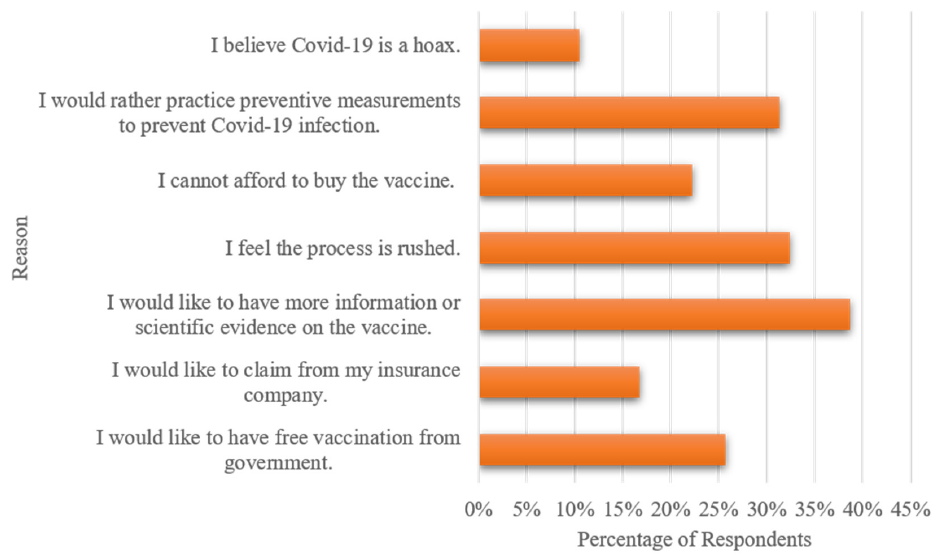
Figure 1. Reasons for rejecting a COVID-19 vaccine.